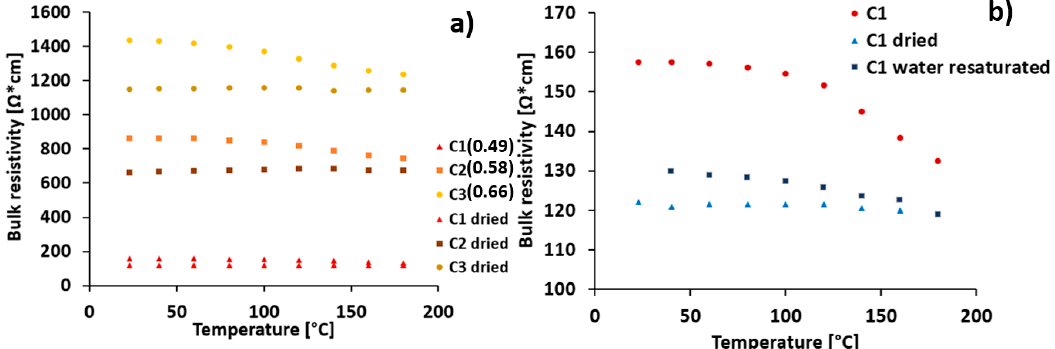
Figure 8. Resistivity changes upon temperature increase for samples with ( a ) different water to cement ratio: C1 (w/c: 0.49), C2 (w/c: 0.58), C3 (w/c: 0.66) and ( b ) different pore volume water saturation The resistivity changes for the reference sample without CNF is presented in Figure S2 in the Supporting Information.